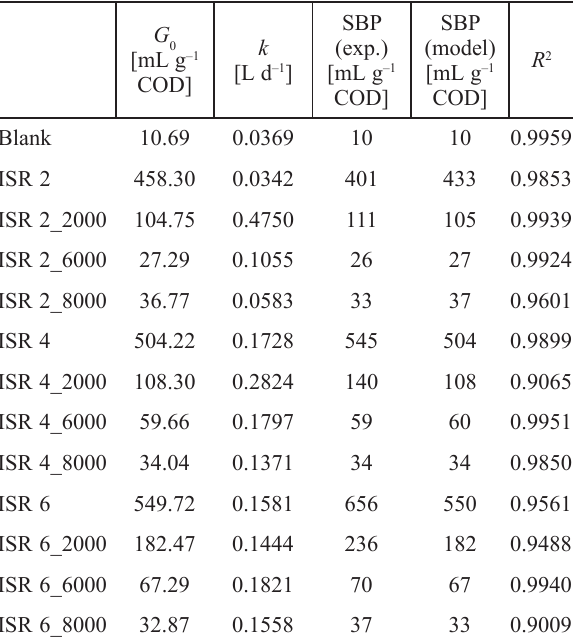
Table 3 – Experimental and calculated kinetic parameters for first order kinetics